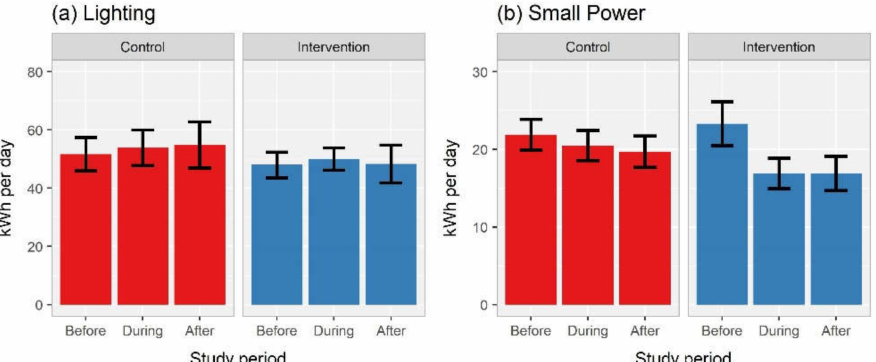
Figure 3. Mean electricity consumption per day (kWh/day) for ( a ) lighting ( b ) small power, comparing the control and intervention study groups for the study periods before (1 September– 31 October 2017), during (1 November 2017–31 January 2018) and after (1 February–30 April 2018) the behavior change intervention. 1 Standard Deviation of the mean is